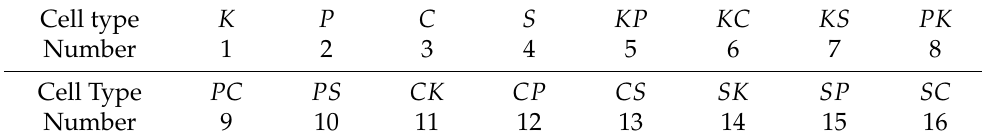
Figure 1. Scheme illustrating the evolution of possible mutations of healthy cell N . The branch following the initial mutation K is shown in detail. For clarity, the evolutionary schemes evolving from the alternative initial P(2), C(3), and S(4) mutations are not included in the diagram. Table 2. An illustration of the enumeration rule for the one-letter and two-letter designated types of mutated